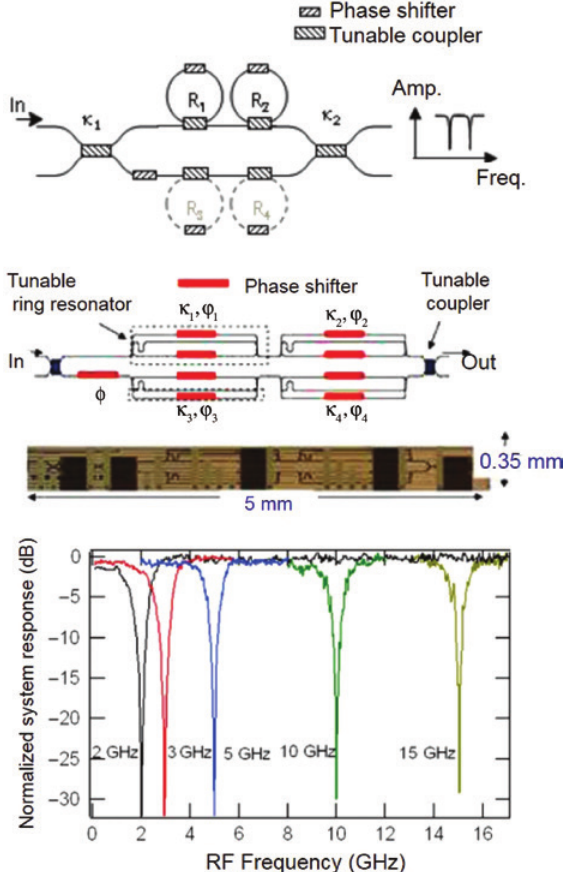
Figure 21: An RF notch filter implemented using an RAMZI circuit in silicon [98] (Copyright in 2007,